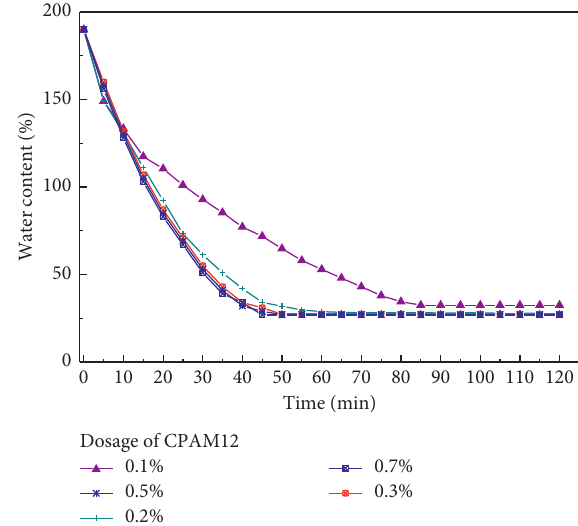
Figure 14: Water content change curve of slurry pressure filtration with different CPAM12